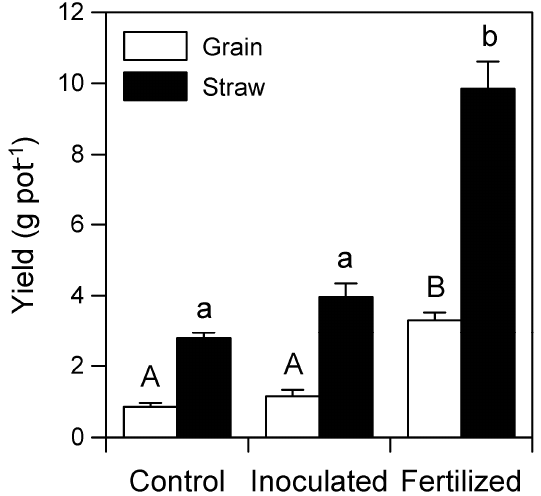
Figure 5. Grain (open bars) and straw yield (g pot − 1 ; filled bars) of Eragrostis tef (30 plants pot − 1 ) in cropland soil (Control), cropland soil inoculated with forest soil (Inoculated) and N-P fertilisation (Fertilized). Different capital/small letters indicate significant differences between treatments; values are the average of three soil types of five replicates each (TukeyHSD, p < 0.05, n = 15; mean ± SE).